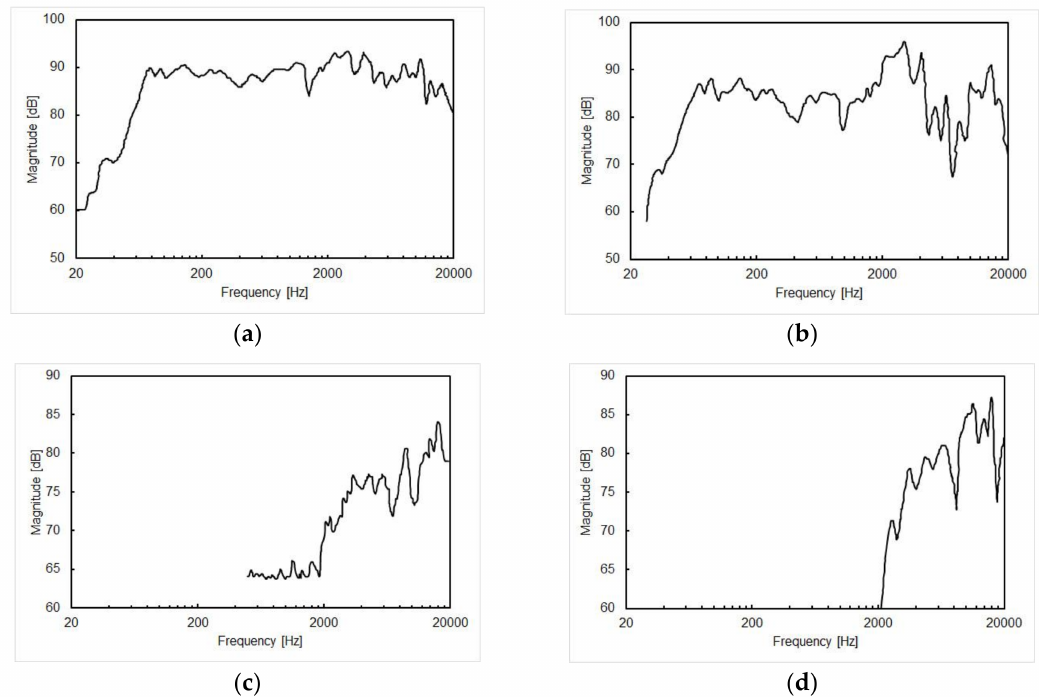
Figure 2. Frequency characteristics of the midrange loudspeaker in cars ( a ) A, ( b ) B and the tweeters in cars ( c ) A, ( d )